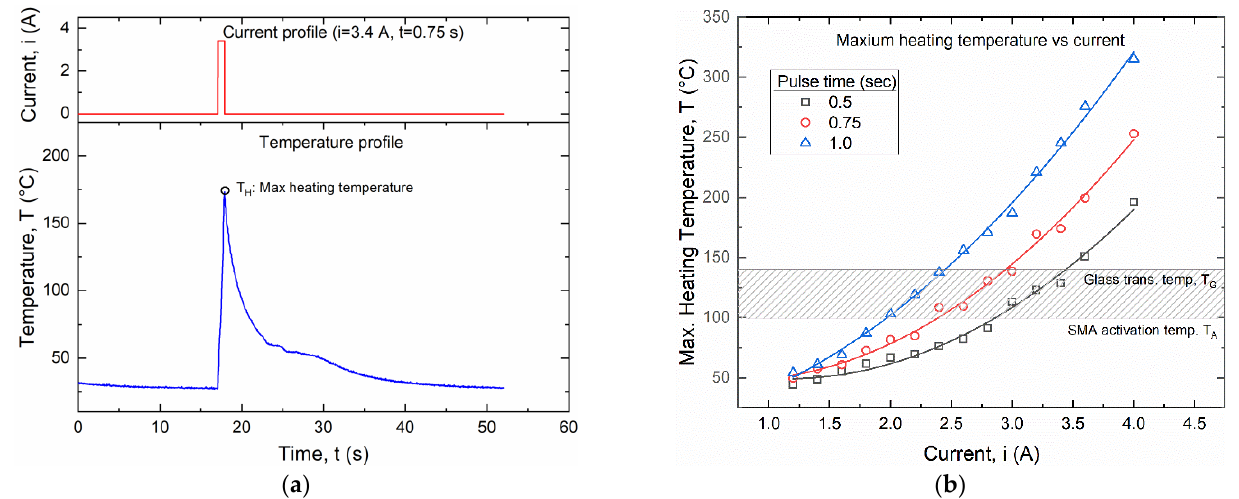
Figure 10. Temperature evolution of the SMA wire for a square current signal with small pulse durations: ( a ) time evolution of the temperature for i = 3.4 A and t = 0.75 s; ( b ) maximum heating temperature (T H ) versus current amplitude (i) for pulse duration of 0.5, 0.75 and 1.0 s.